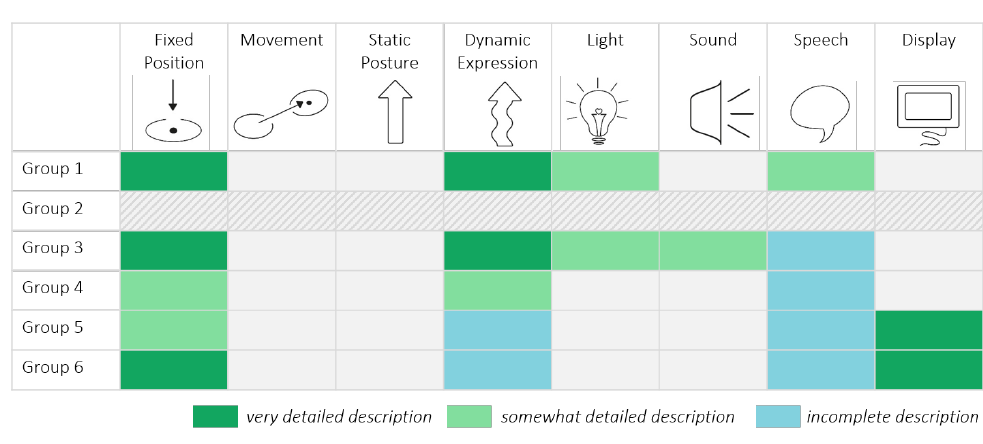
Figure 8. Overview of communication modalities used by the groups to create multi-modal behaviors for the positive feedback situation.